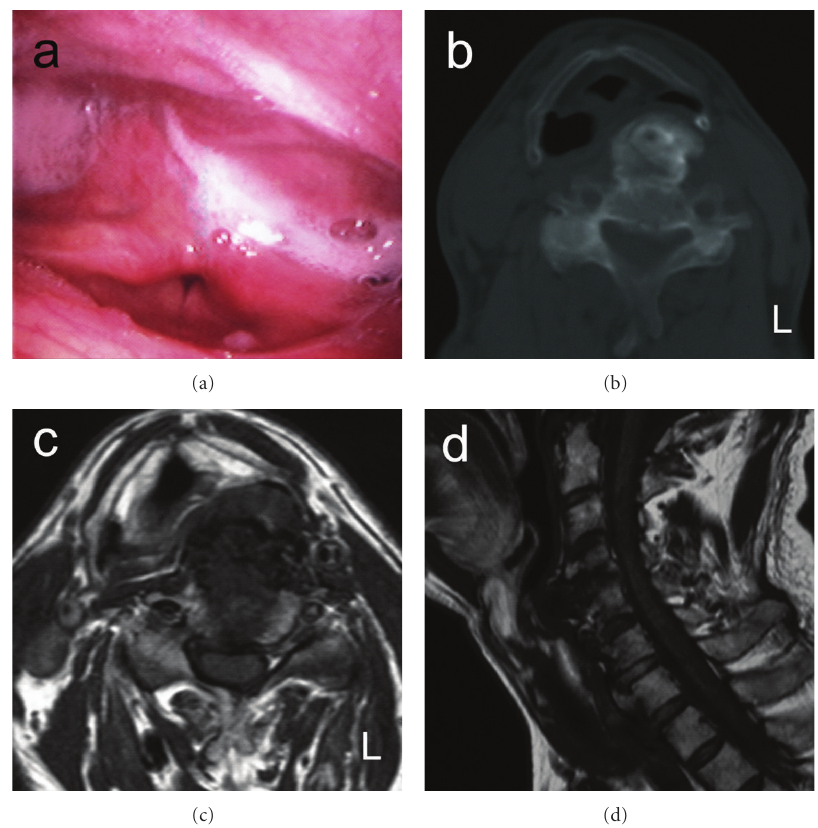
Figure 1: (a) a hard mass protruding in the posterior hypopharyngeal wall. (b) CT scan shows a bony mass pushing the posterior piriform sinus wall anteriorly. (c) Axial T1 weighted-MRI shows a mass pushing the posterior piriform sinus wall anteriorly. (d) sagittal T1 weighted- MRI shows an anterior mass of the cervical spine from C4 to